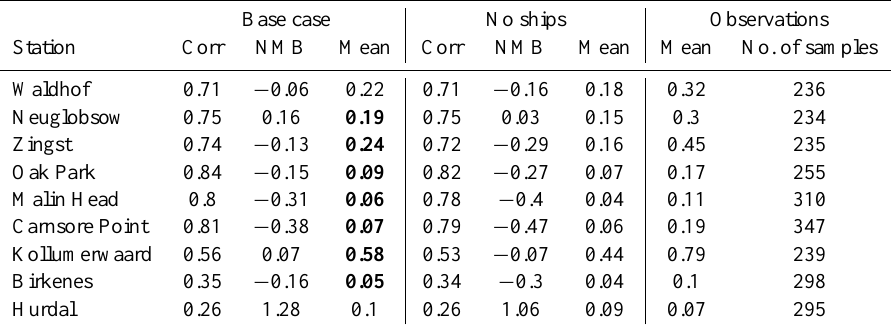
Table 8. Comparison of simulated NO − concentrations with observations in µgm − 3 . Values that are significantly different between the base 3 case and the no-ships case are printed in